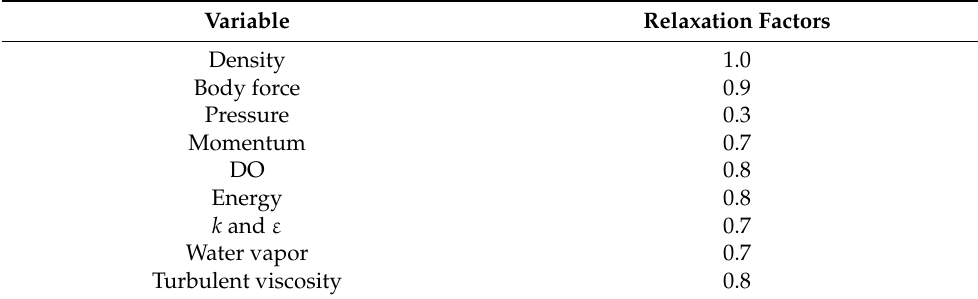
Table 1. Relaxation factors used in the CFD